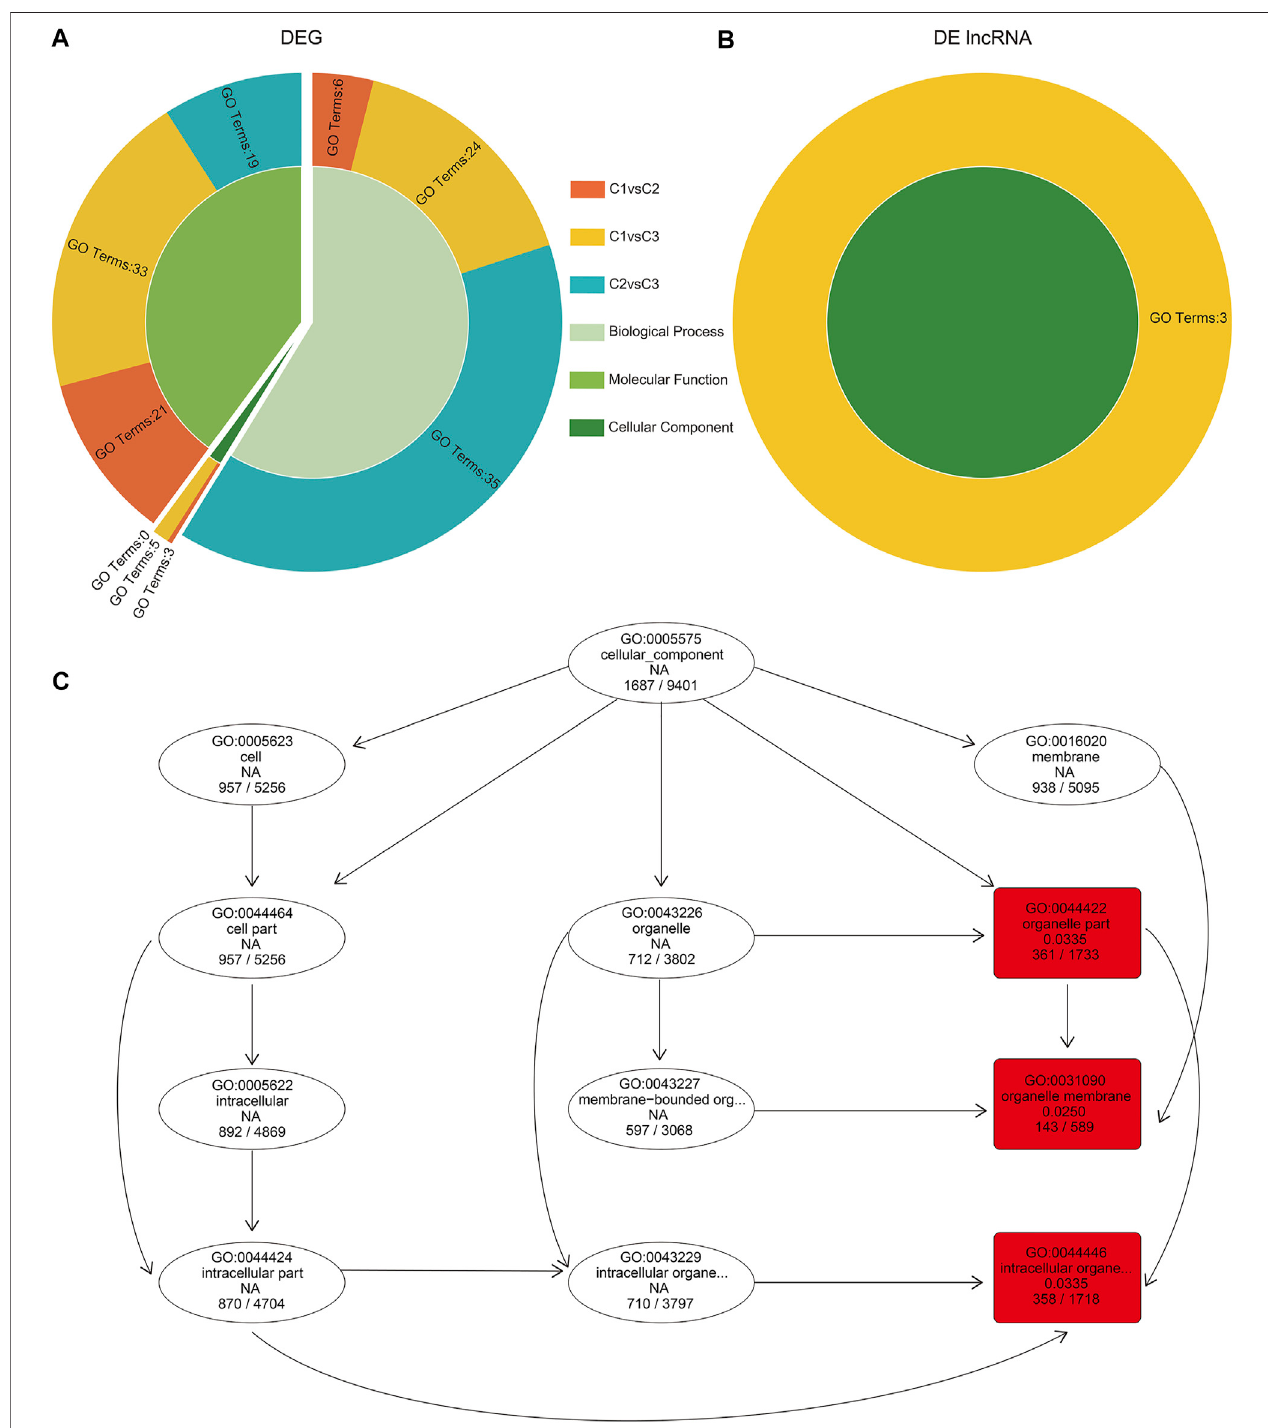
FIGURE5| GeneOntology(GO)enrichmentanalysisofDEGsandcis-actingtargetgenesofDElncRNAinhickoryfemale fl oraldevelopment. (A,B) GOenrichment of DEGs and DE lncRNA cis-acting target genes in comparison to C1, C2, and C3 hickory female fl oral development. (C) The enriched GO terms (red boxes) for cis- acting target genes of lncRNAs in the cellular component of C1vsC3.